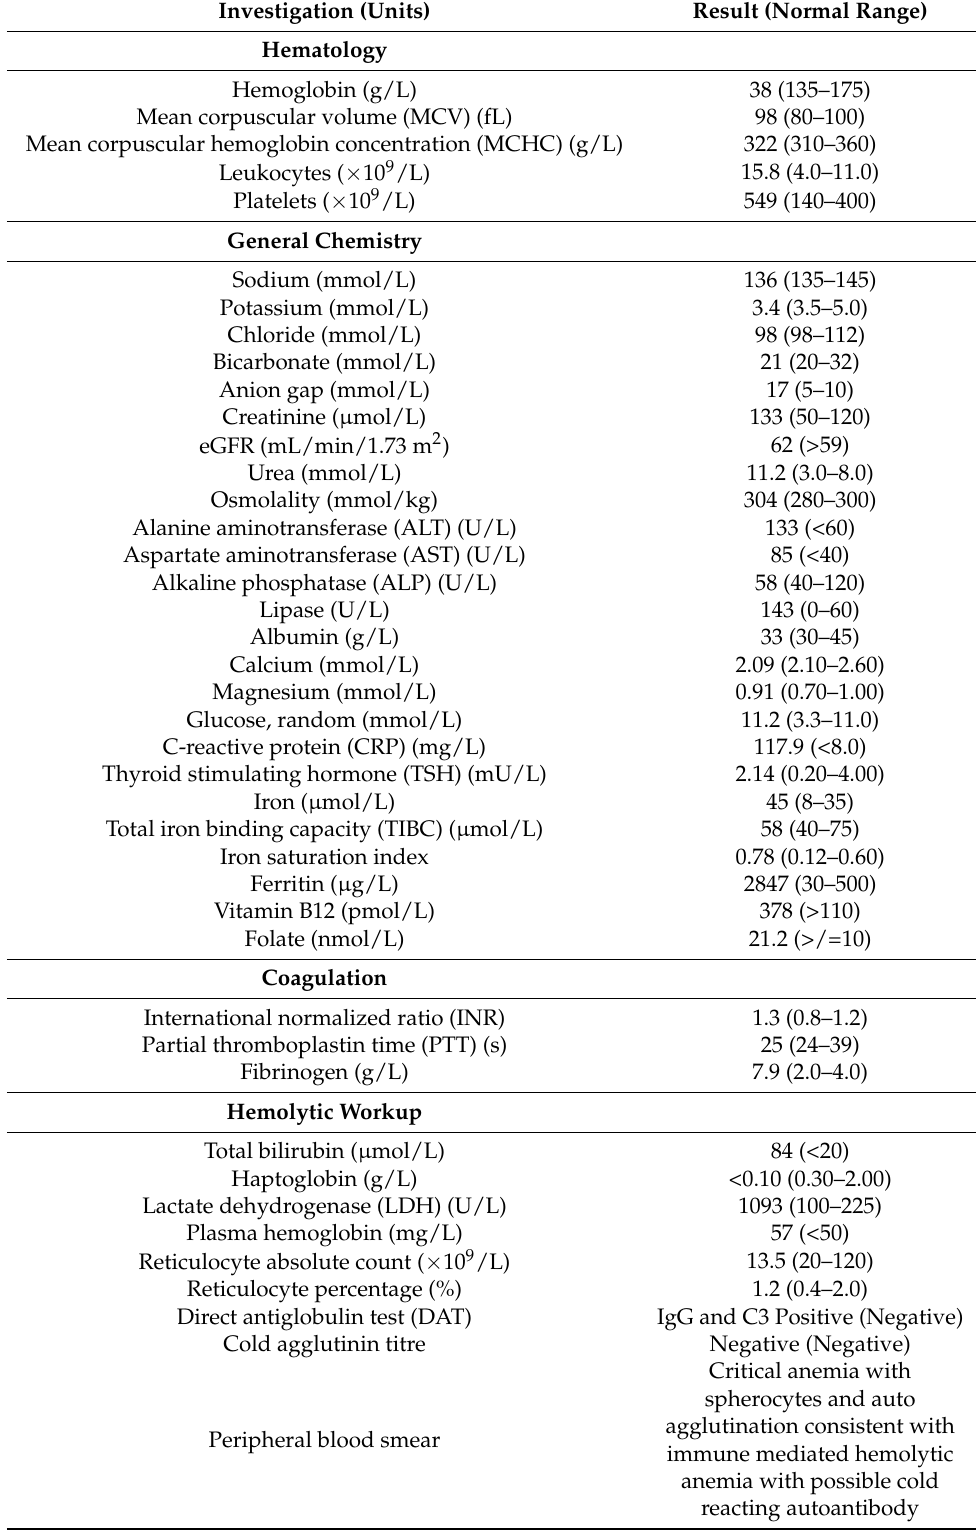
Table 1. Summary of select patient laboratory investigations on